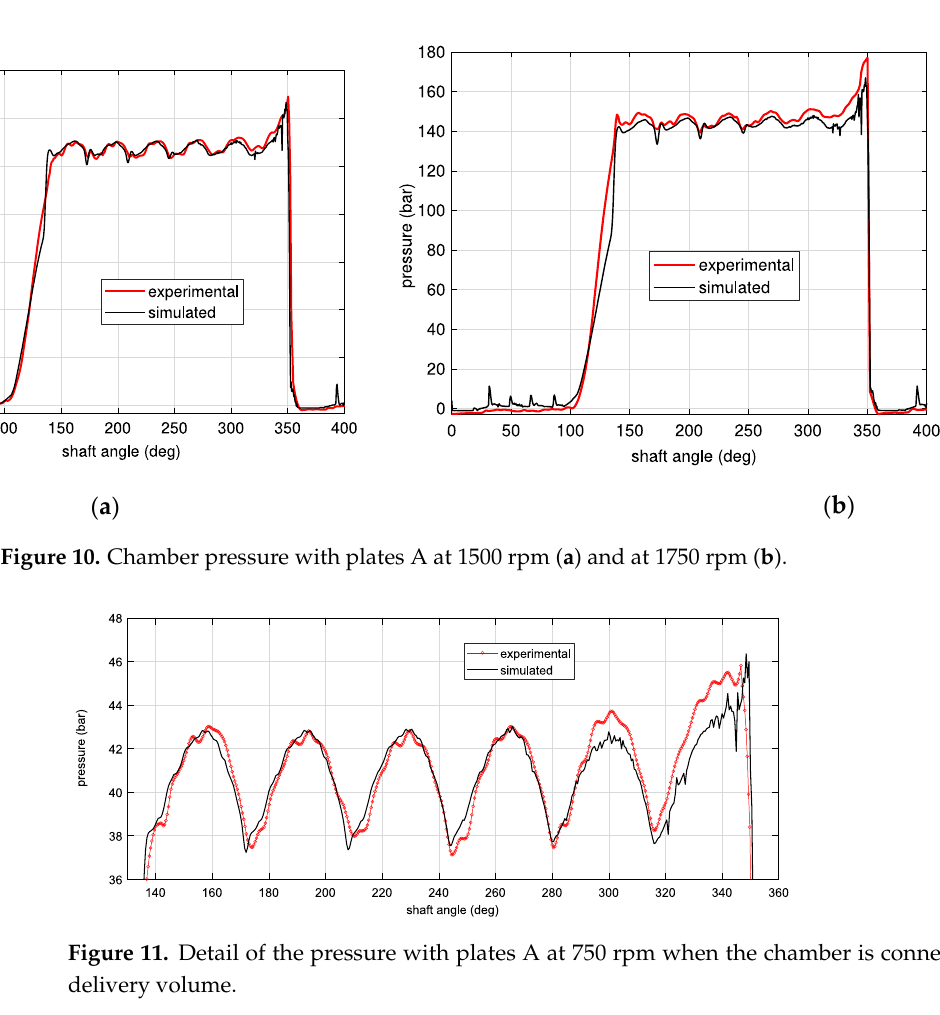
Figure 9. Chamber pressure with plates A at 750 rpm ( a ) and at 1250 rpm ( b ).